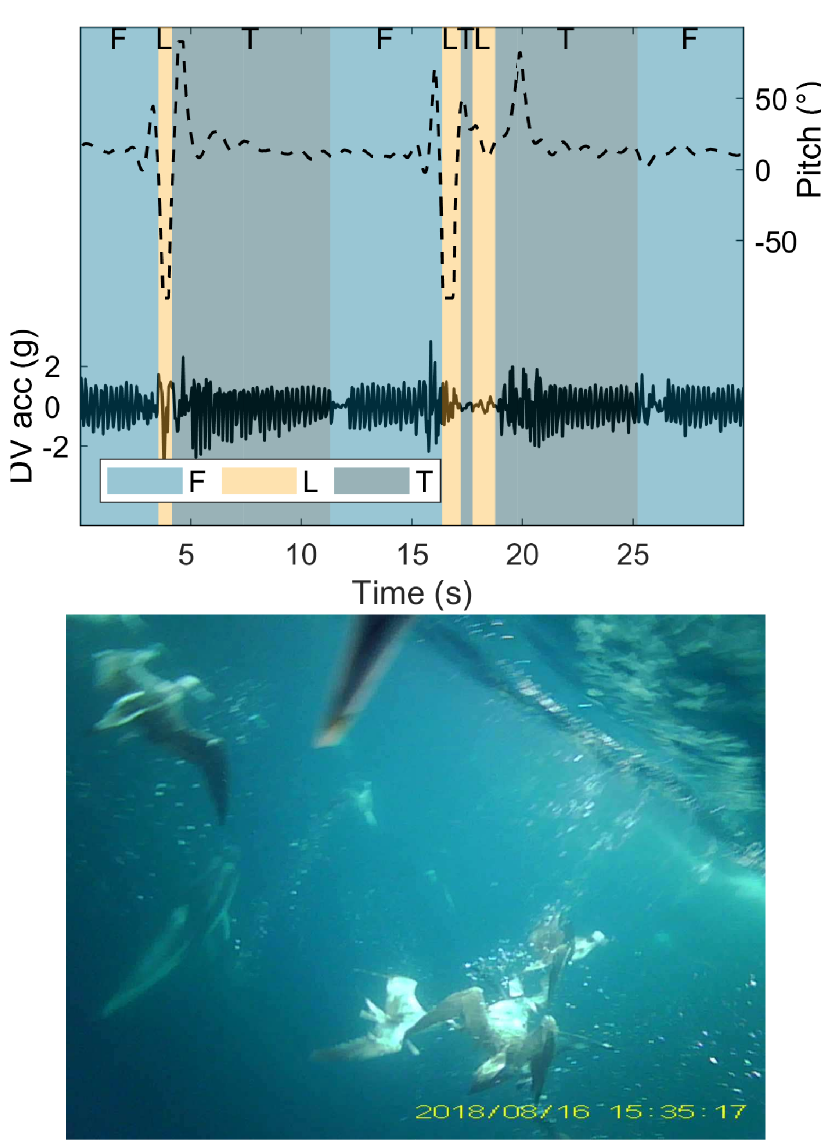
Fig 3. Foraging dive example. The dynamic dorsoventral acceleration (DV acc; solid line) and pitch (dashed line) during two foraging dives between periods of flight (top). The colour of the background refers to the behaviour observed, flight (F), landing (L), and take-off (T), and each behaviour is labelled above. During these landings, the water surface can be observed from underneath during the video recording, suggesting full submersion of the bird. Below is a screenshot from a video-recording showing another shearwater completely submerged during a foraging